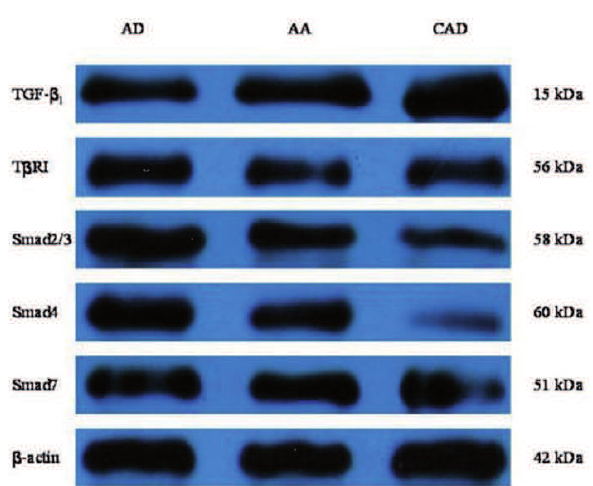
Fig. 2. Western blot of TGF-ß